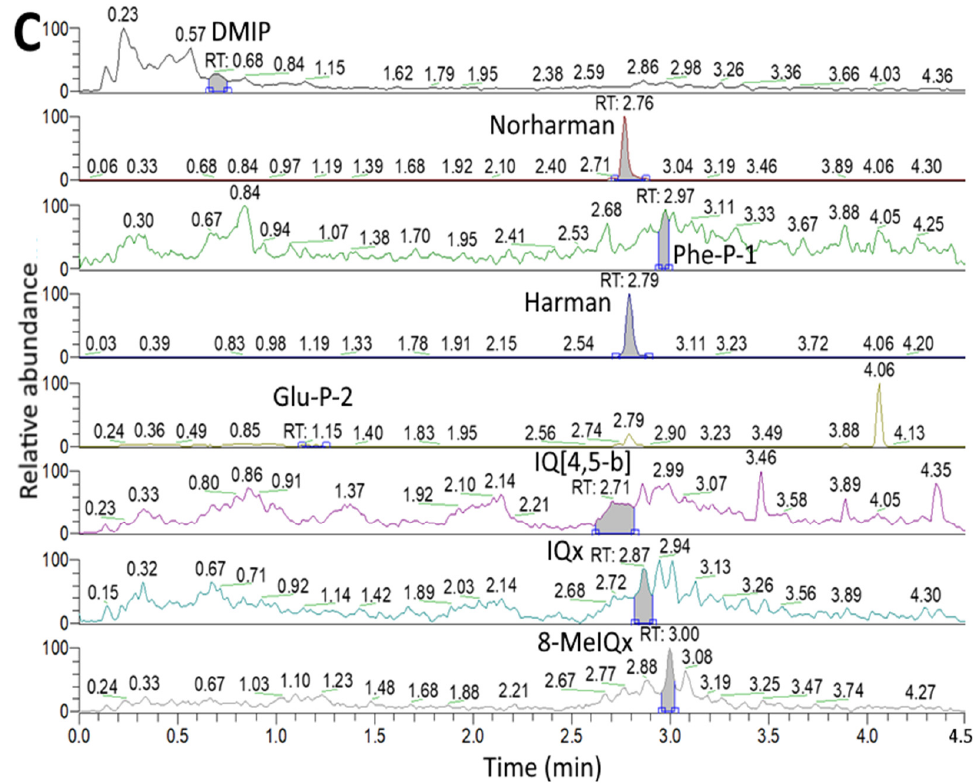
Figure 2. UPLC-MS/MS chromatogram of HAs in marinated juice ( A ), marinated juice with 0.5% cinnamon powder after 24 h marinating ( B ) and marinated juice with 0.5% green tea powder after 24 h marinating ( C ), as detected by SRM mode. Table 1. HAs contents (ng/g) in marinated pork and juice as affected different flavorings and time